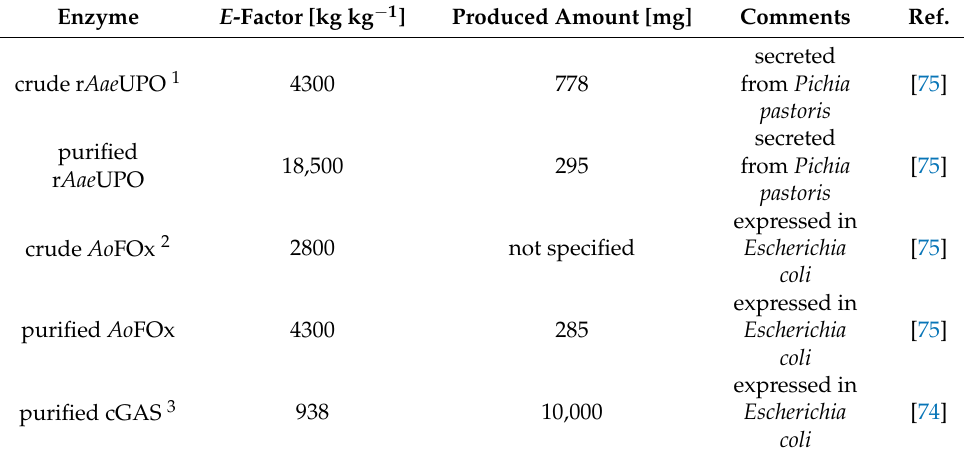
Table 3. E- factors for enzyme